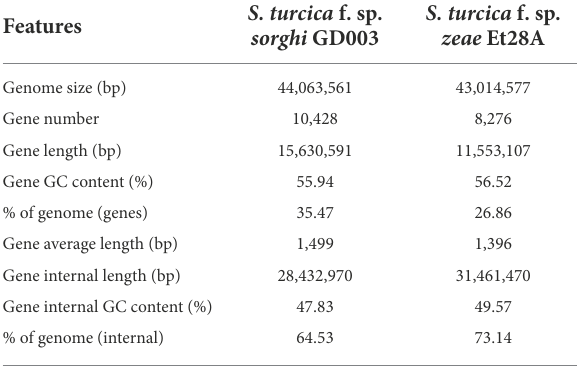
TABLE 2 Number of genes annotated by different functional databases in Setosphaeria turcica f. sp. sorghi GD003 and S. turcica f. sp. zeae Et28A